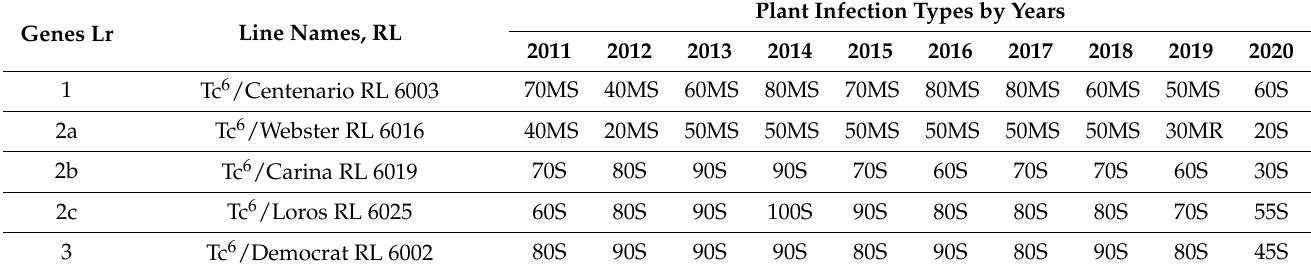
Table 1. Immunological assessment of near isogenic Thatcher lines for resistance to the North Caucasian P. triticina population (infectious site of FSCBPP, 2011–2020).